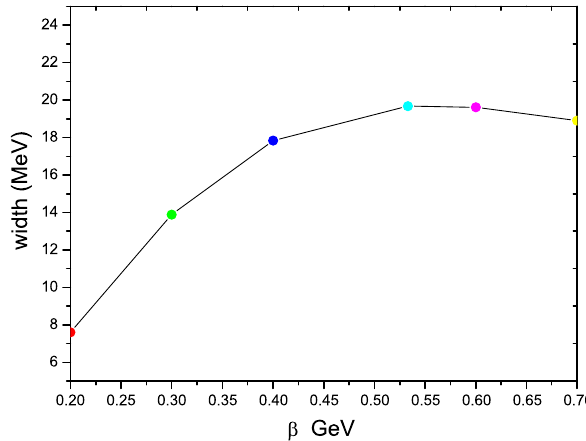
Fig. 4 The dependence of (cid:3)( X ( 5568 ) → B s π + ) on β